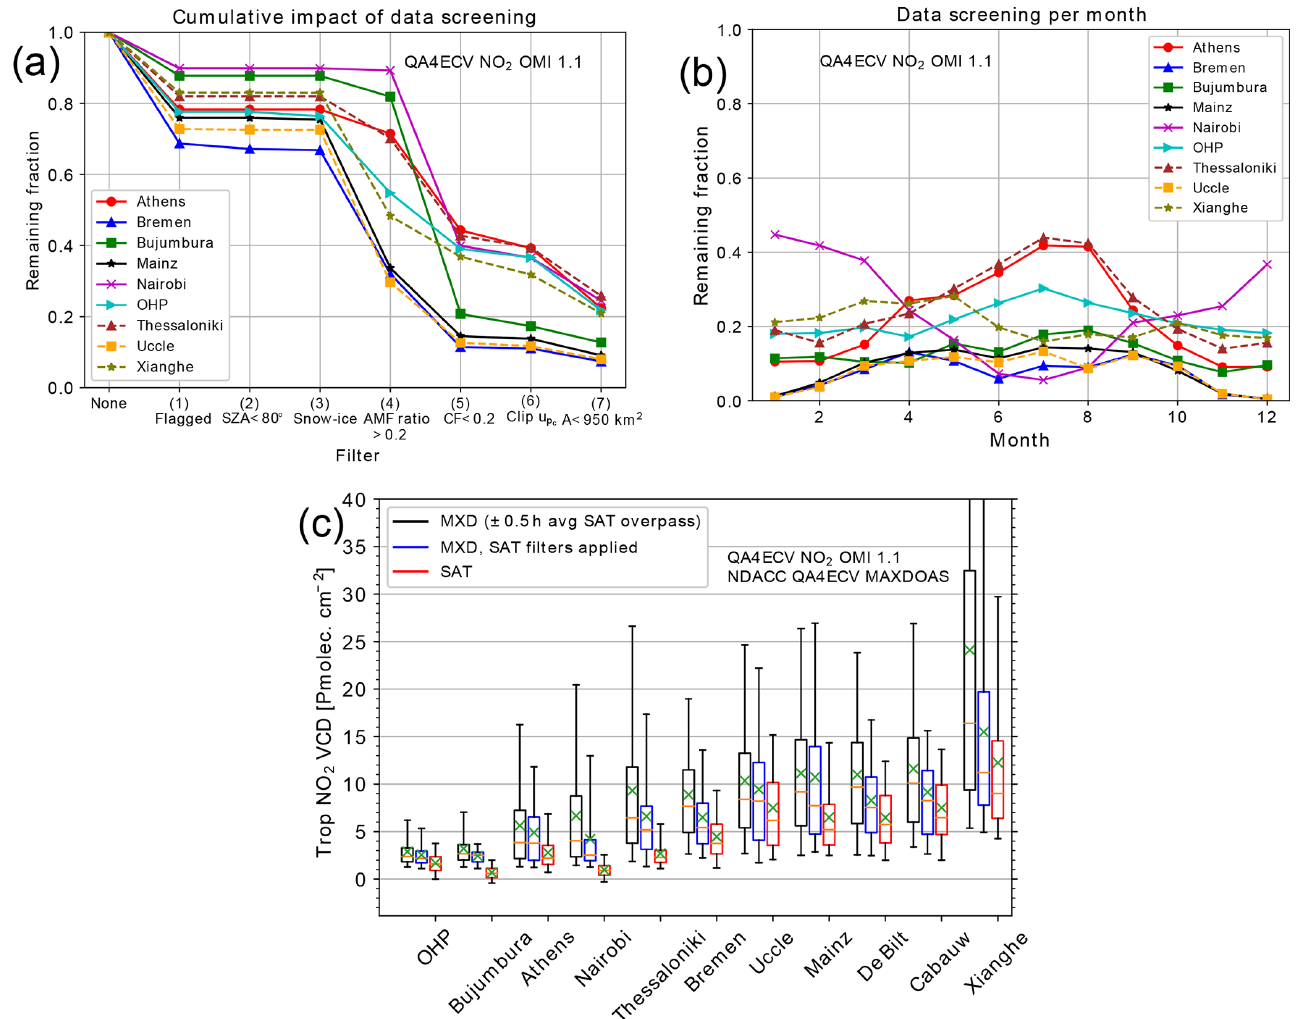
Figure 3. Starting from satellite data with a ground pixel covering the MAX-DOAS site, panel (a) shows the remaining data fraction after the application of each of the seven filter criteria. The criteria are explained in Sect. 3.1.1. The Cabauw and De Bilt sites are not included here, as the fractions are very close to that of Uccle. Panel (b) shows the remaining fraction per month after the application of all filters. Panel (c) shows boxplots of QA4ECV MAX-DOAS data (“MXD”) co-located with QA4ECV OMI for each site, before the application of the filters (black), after the application of the filters (blue) and QA4ECV OMI co-located with MAX-DOAS after the application of the filters (“SAT”, red). The sites are sorted according to the median MAX-DOAS value before filtering. The box edges represent the 1st and 3th quartiles, the orange line represents the median, the green cross represents the mean, and the whiskers represent the 5th and 95th